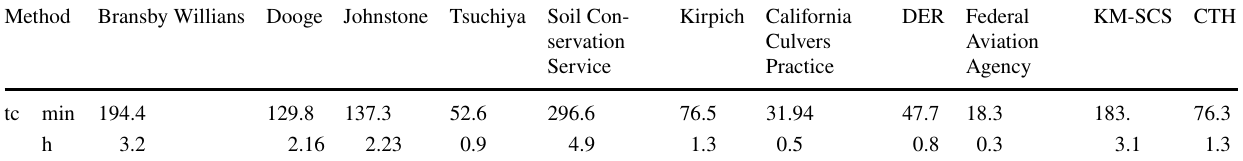
Fig. 4 Unit hydrograph of the flow sensitivity analysis accord- ing to the tc. Ribeirão do Suru watershed, Santana de Parnaíba, SP. Source Author (2020)